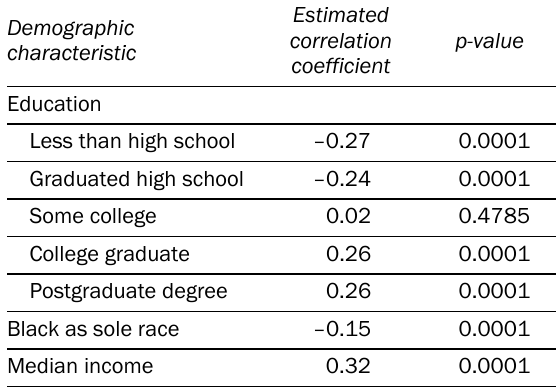
Table 2. Bivariate Correlation Coefficients Between Organic Food Index and